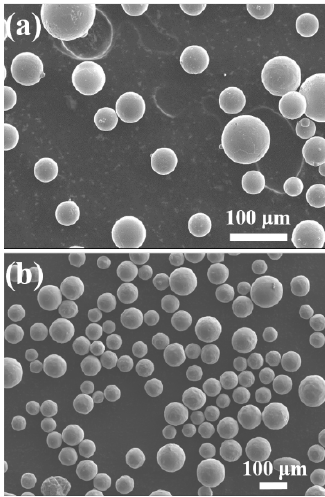
Figure A1. The secondary electron image of Ti6Al4V powder in ( a ) fresh powder and ( b ) recycle powder. Both types of powder were spherically shaped.